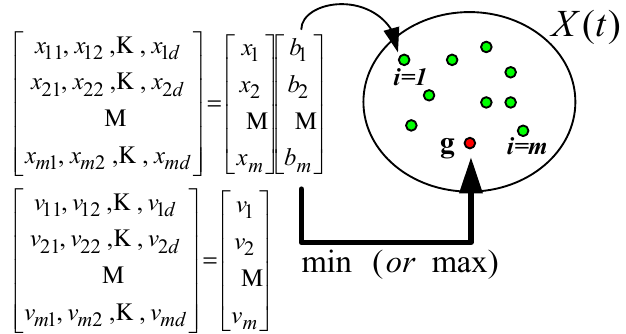
Figure 2. Particle swarm optimization algorithm: Position, velocity, and personal and global best variables data representation.